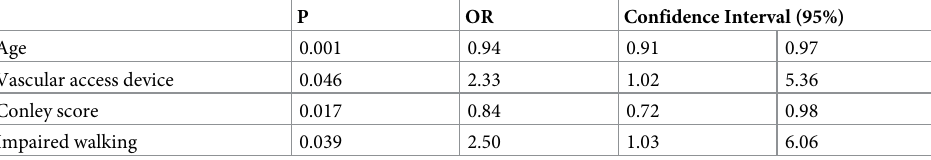
Table 4. Logistic regression model to assess factors associated with acute hospitalization during CH